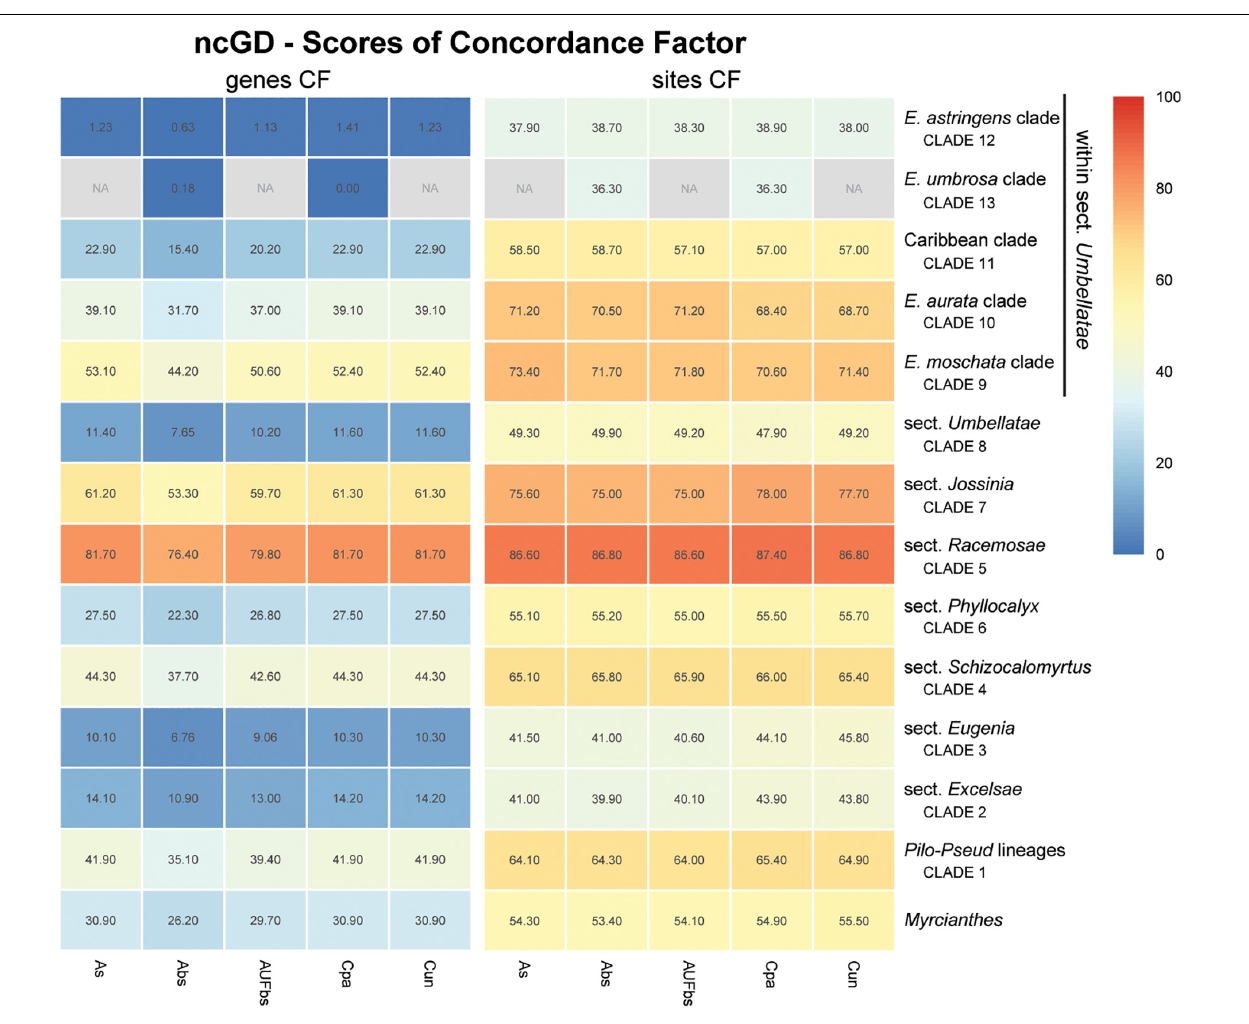
FIGURE 8 | Heatmap of gene and site concordance factors (gCF and sCF) recovered in focus clades resulting from combination of nuclear coding and intronic non-coding loci in a genomic dataset (ncGD) of Eugenia . Each column is a method of phylogenetic reconstruction, and each row corresponds to a clade in Figures 2–4 . Shading indicates percentage of concordance factor values recovered (Cpa, concatenated and partitioned ML reconstruction; Cun, concatenated and unpartitioned ML reconstruction; As, coalescent Astral tree with local posterior probability support; Abs, coalescent-based Astral tree with 100 bootstrap replicates; AUFbs, coalescent Astral tree with 1,000 ultrafast bootstrap replicates; NA, node not